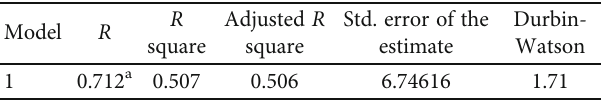
Table 6: Model summary of self-assessment (SA) and professional development (PD).